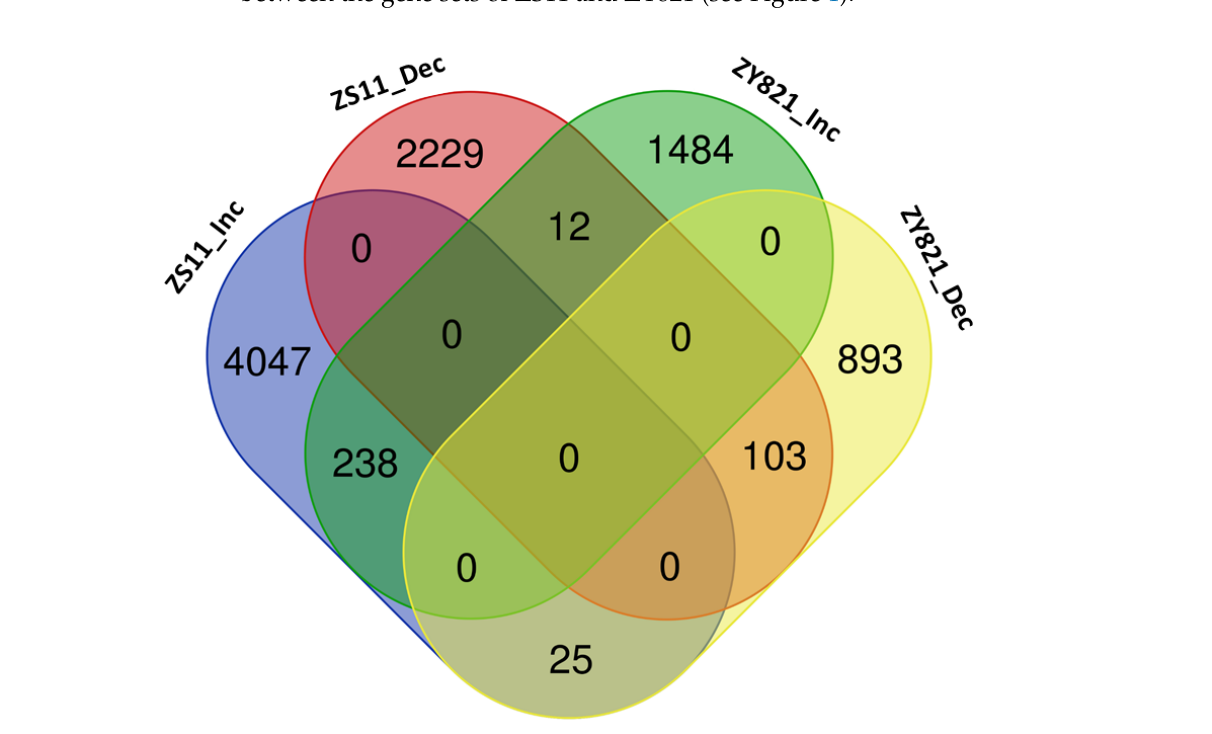
Figure 1. Venn-diagram of the MEGs expressed in ascending and descending orders for the seeds of two cultivars ZS11 and ZY821. (ZS11_Inc: Ascendings MEGs for ZS11; ZS11_Dec: Descending MEGs for ZS11; ZY821_Inc: Ascendings MEGs for ZY821; ZY821_Dec: Descending MEGs for ZY821) (visualised with